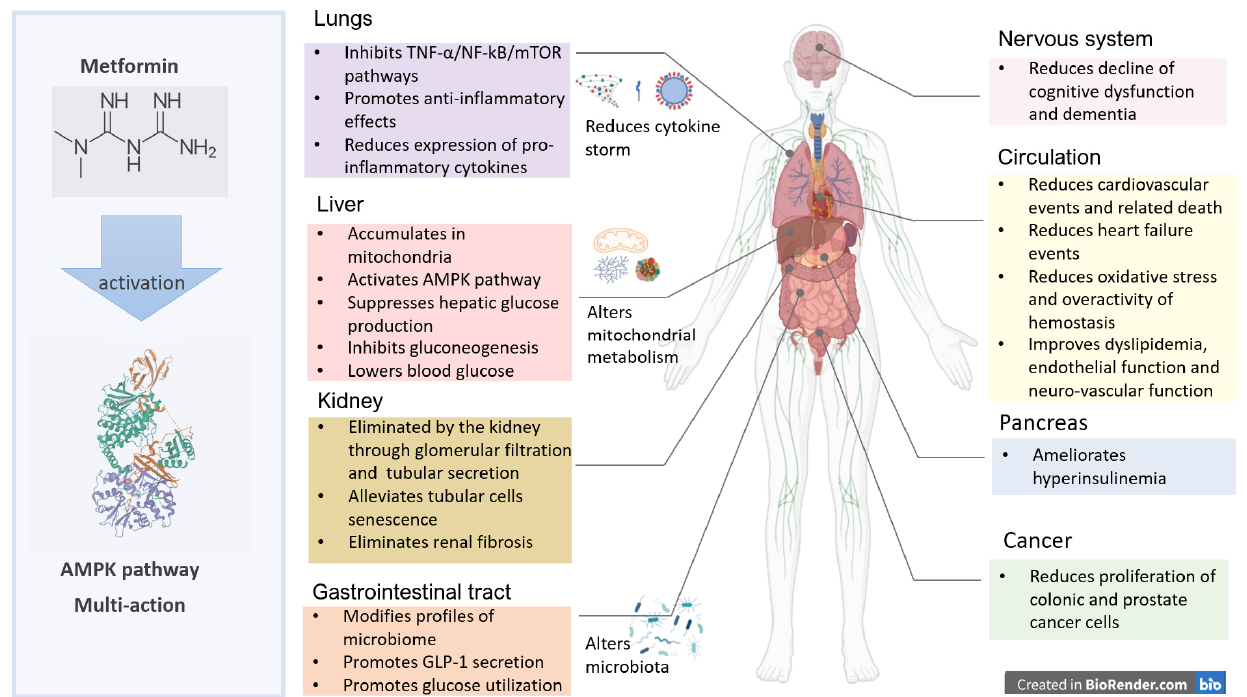
Figure 2. Clinical benefits of metformin in multiple systems. The multi-targeted actions of metformin are mediated both by the adenosine monophosphate activated protein kinase (AMPK) pathway and non-AMPK pathways. In the liver, metformin reduces glycogenolysis, hepatic glucose production, and gluconeogenesis [37]. In the lung, metformin modulates the tumor necrosis factor (TNF)- α /NF-kB/mammalian target of rapamycin (mTOR) pathways and expression of pro-inflammatory cytokines. In the intestines, metformin modifies gut microbiome and promotes incretin (e.g., glucagon-like peptide 1, GLP-1) secretion with increased glucose utilization. In the nervous system, metformin reduces amyloid plaque formation and decline of cognitive function. In the circulatory systems, metformin improves dyslipidemia and endothelial dysfunction with reduced cardiovascular–renal events. Metformin reduces site-specific cancer events, including prostate and liver, in part due to amelioration of insulin resistance with reduced activation of insulin/insulin-like growth factor (IGF-1). Metformin is eliminated by the kidney. Metformin alleviates podocyte loss, mesangial cells apoptosis, and tubular cells senescence through AMPK-mediated signaling pathways. In chronic kidney disease, renal fibrosis is ameliorated by metformin, mainly via AMPK activation. Reduced glomerular filtration and tubular secretion may lead to accumulation of metformin and increased risk of lactic acidosis, especially in stress situations [17] (adapted from reference